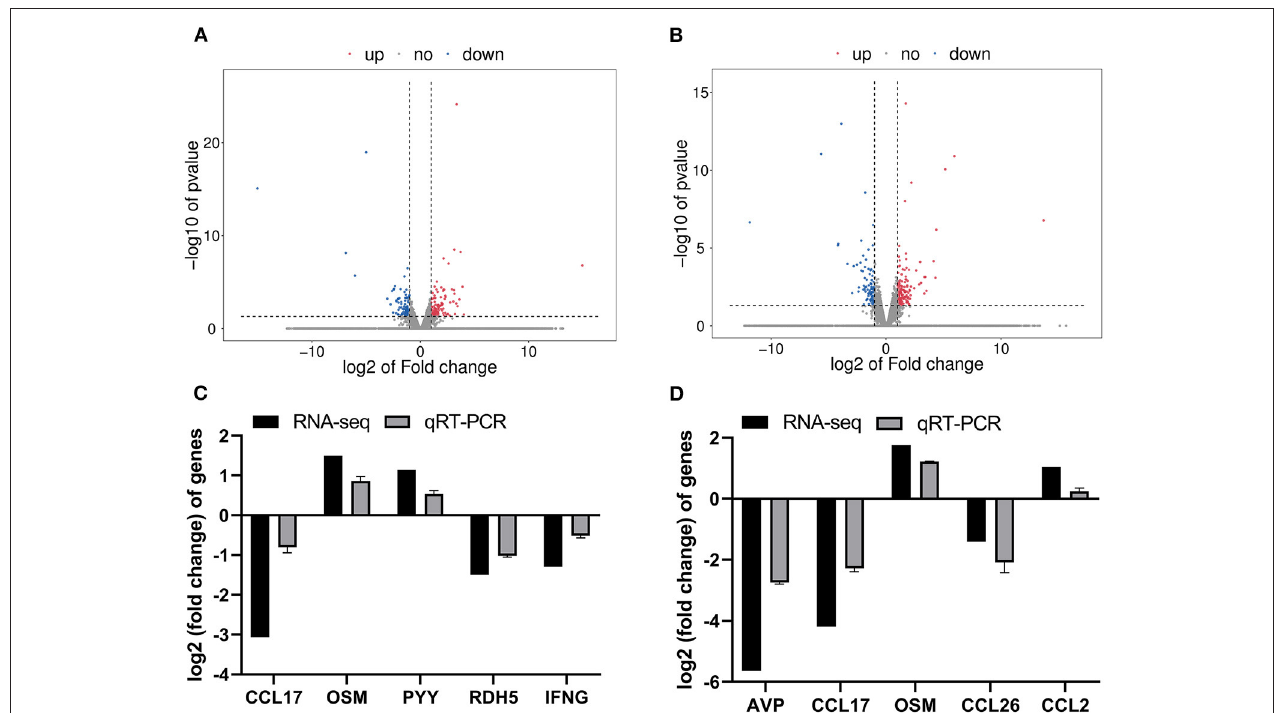
FIGURE 1 | The RNA-seq analysis of different social contact patterns in the colonic mucosa of piglets. (A) Volcano plot of DEGs between ISC and CON groups. (B) Volcano plot of DEGs between CSC and CON groups. (C) The relative gene expression levels and transcriptional FPKM between ISC and CON group. (D) The relative gene expression levels and transcriptional FPKM between CSC and CON group. Gene expression at mRNA level was calculated by RT-PCR. The RT-PCR results were analyzed by Student’s t -test and the results were represented as mean ± SEM ( n = 3). ISC, intermittent social contact; CSC, continuous social contact; CON, control; FPKM, base exon fragments per million